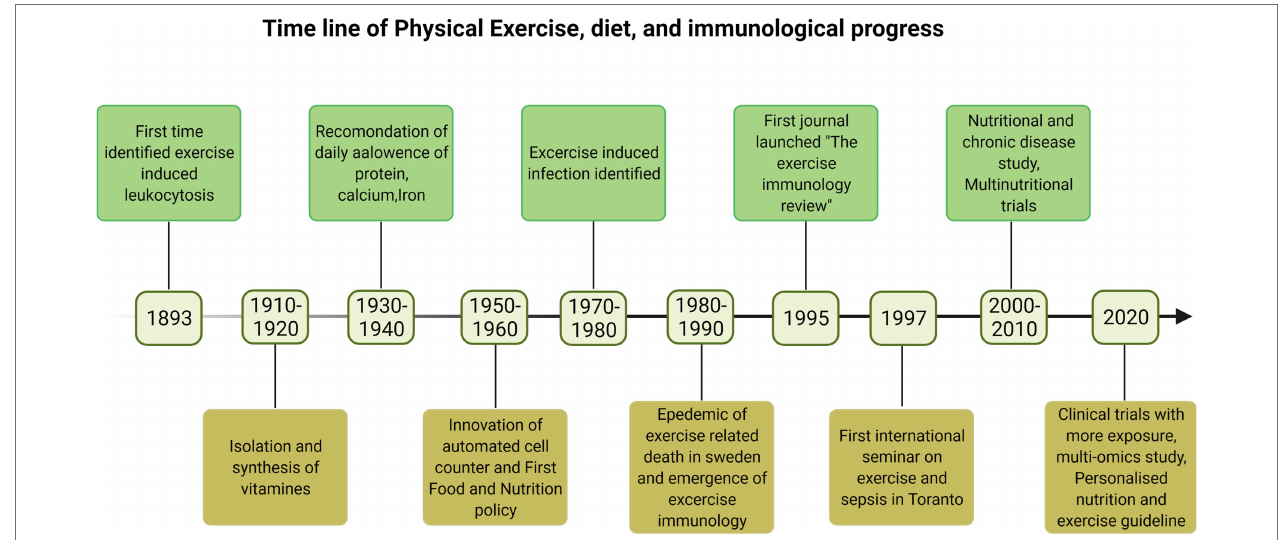
FIGURE 1 | The timeline of the early development of immunology and discoveries in physical exercise and diet impacting the immune system (Doherty and Robertson, 2004; Kaufmann,